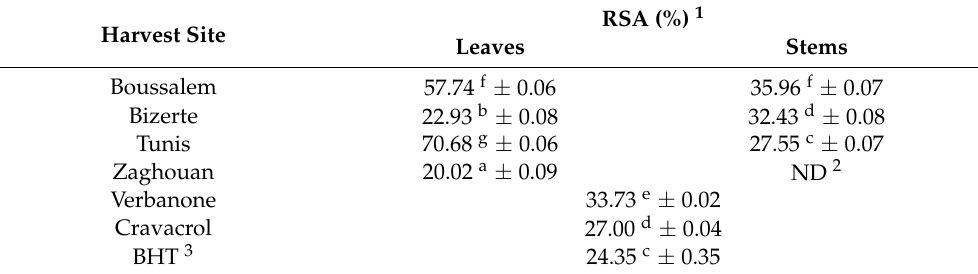
Table 3. Radical scavenging activity (RSA) of essential oils evaluated by the DPPH